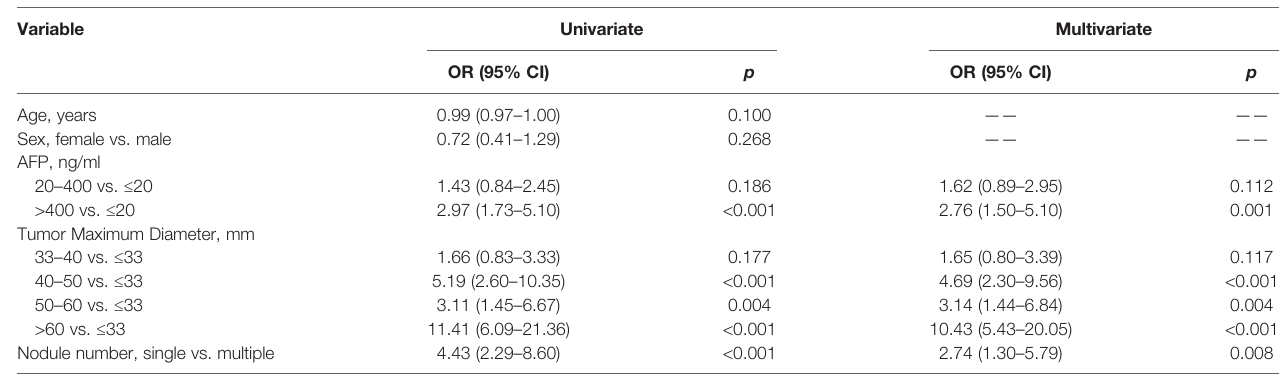
vs. 63.4%, p = 0.05 in the validation group; 71.4% vs. 38.1%, p = 0.03 in the test group). The CECL-DCNN model, which incorporated CEUS video and clinical parameters, achieved not only higher speci fi city (86.6% vs. 63.4%, p < 0.001 in the validation group; 81.0% vs. 38.1%, p = 0.005 in the test group) but also higher accuracy than the Clinical model (81.4% vs.